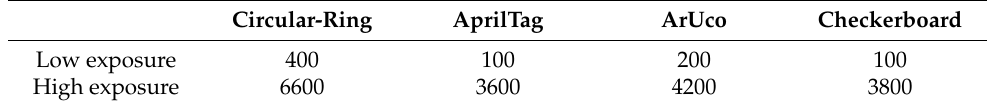
Figure 9. The time of exposure is 100 µ s, 1000 µ s, 3300 µ s, and 6600 µ s. Table 3. The effective range of the exposure time [ µ s].